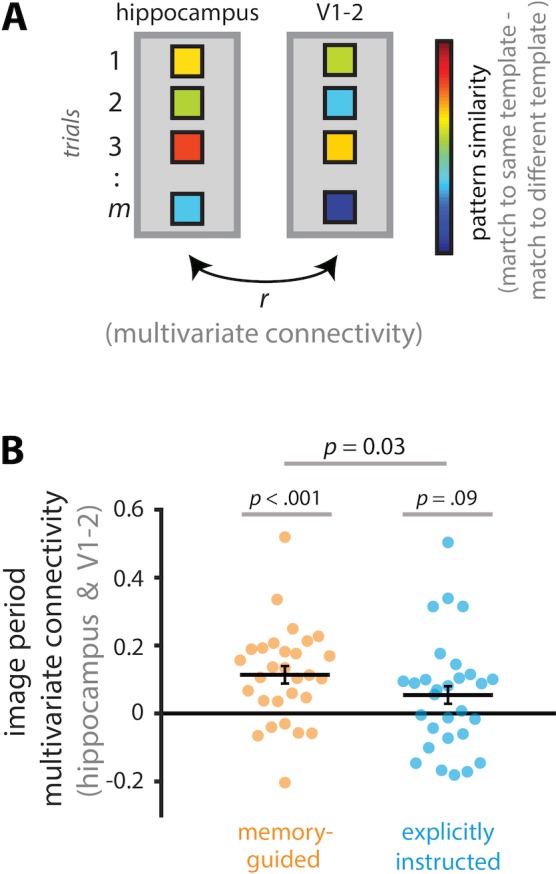
Multivariate connectivity between the hippocampus and V1-2.(A) To calculate multivariate connectivity, we first created art and room attentional state ‘templates’ by averaging image period activity patterns across trials, separately for art and room attentional states. Second, these templates were correlated with activity patterns for individual trials, separately for same (i.e., art trial-art template, room trial-room template) and different (i.e., art trial-room template, room trial-art template) attentional states. Third, for each trial, we calculated a measure of multivariate attentional state ‘quality’ by subtracting its correlation with the different state template (e.g., art trial-room template) from its correlation with the same state template (e.g., art trial-art template). These steps were performed separately for the hippocampus and V1-2. Lastly, we computed multivariate connectivity between the hippocampus and V1-2 by correlating their multivariate attentional state ‘quality’ scores across all trials. (B) Multivariate connectivity was greater than zero for the memory-guided task, but not different from zero for the explicitly instructed task, and the difference between tasks was statistically significant. The results are shown as Pearson correlations, but statistical tests were performed after applying the Fisher transformation. Circles and solid lines show individual-participant and average multivariate connectivity values, respectively. The error bars indicate standard error of the mean for the within-participant task difference (i.e., memory-guided - explicitly instructed).